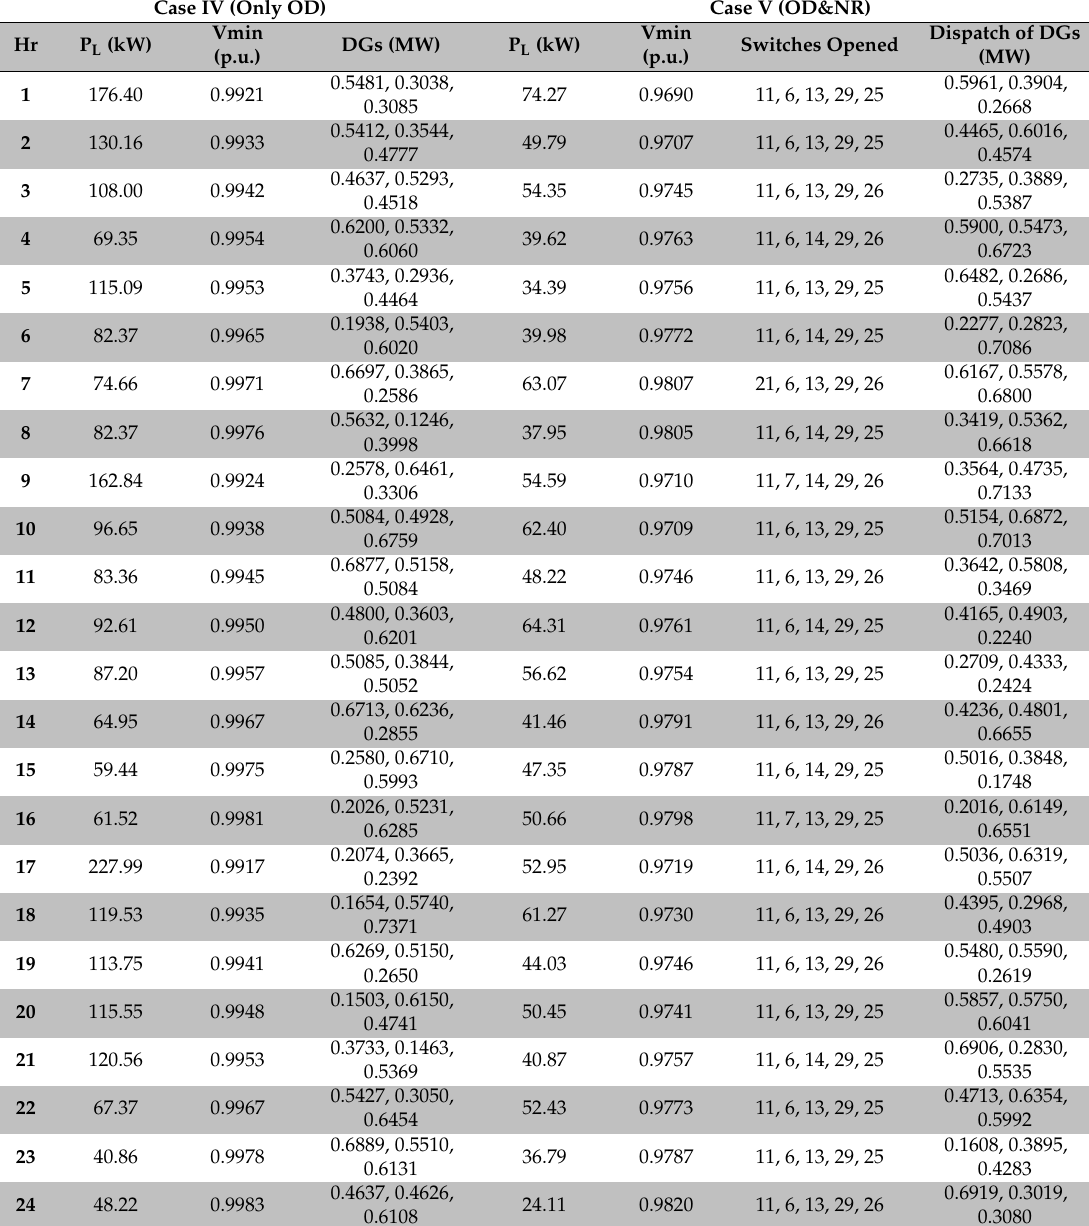
Table 7. 24-h period resolution in the presence of WT (cases IV–V). OD: optimal